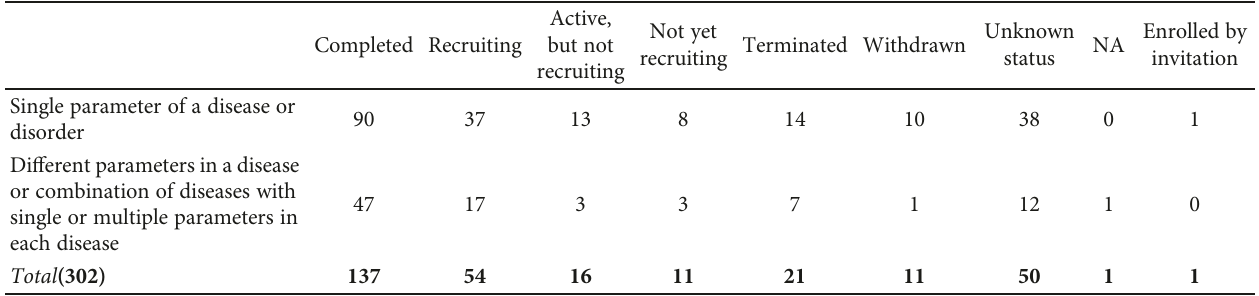
Table 2: Current status of EPC clinical trials related to various disorders and diseases. The table outlines the total number of clinical trials reported on ClinicalTrials.gov till